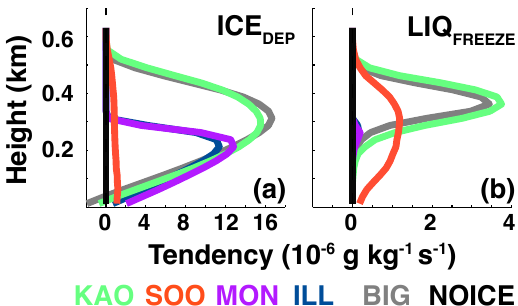
Fig. 7. Vertical profiles of domain-averaged microphysical tenden- cies for the second half of the 12h simulation period from simula- tions featuring different insoluble mass types (color coded at bot- tom). Included are profiles of ice depositional growth tendency (a) and liquid freezing tendency (b)